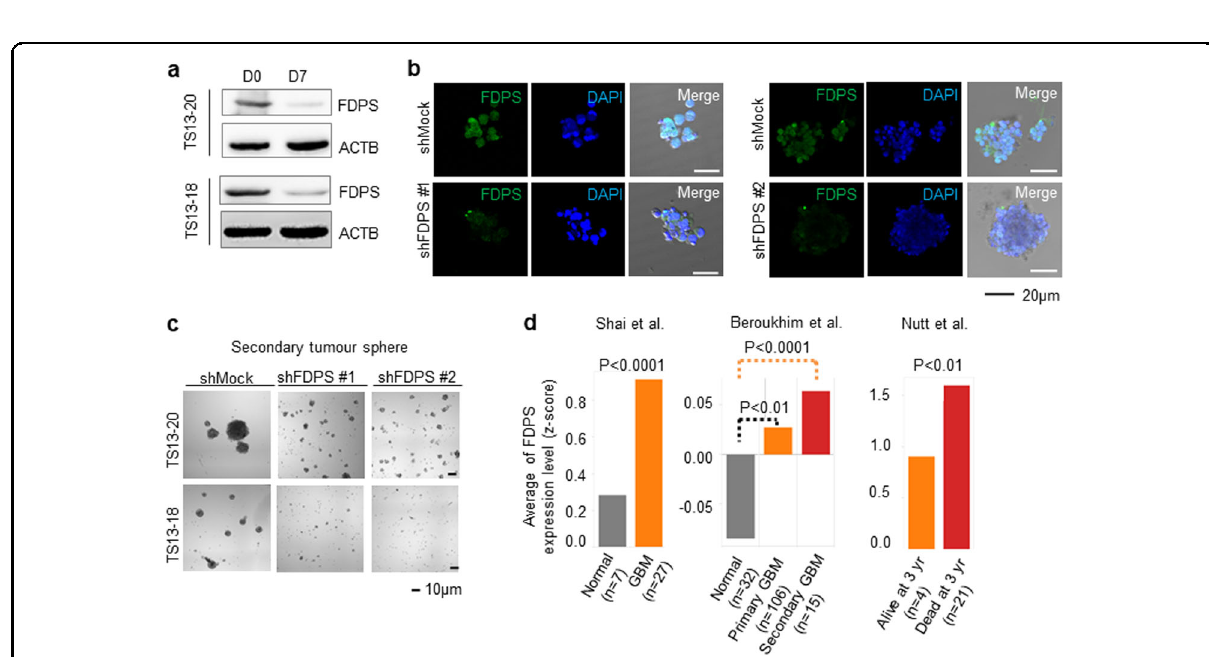
Fig. 4 Knockdown of farnesyl diphosphate synthase (FDPS) suppresses glioblastoma sphere formation. a The protein levels of FDPS between TS13-20 and TS13-18 cell spheres (D0) and differentiated counterparts (D7) were analyzed by western blot. ACTB was used as the loading control. b TS13-20 cells were infected with lentivirus harboring short hairpin RNAs (shRNAs) against FDPS. Two days after infection, the infected cells were selected for 2 days and then maintained an additional 4 days. Knockdown of the FDPS protein was assessed by immuno fl uorescence staining and confocal microscopy. Images were obtained at ×20 using an LSM510 META or LSM780 confocal microscope (Carl Zeiss, Jena, Germany). c Knockdown of FDPS inhibited secondary sphere formation. The same number of control and FDPS knockdown cells were subjected to secondary sphere formation. Bright fi eld images were obtained using a Cytation 3 microplate reader (Bio-Tek). d FDPS gene expression was signi fi cantly upregulated in glioblastoma cells compared with normal cells and in samples with a dead status at 3 years compared with samples with a live status. Three independent microarray-based data sets were median centered and normalized to the unit standard deviation to compare the gene expression